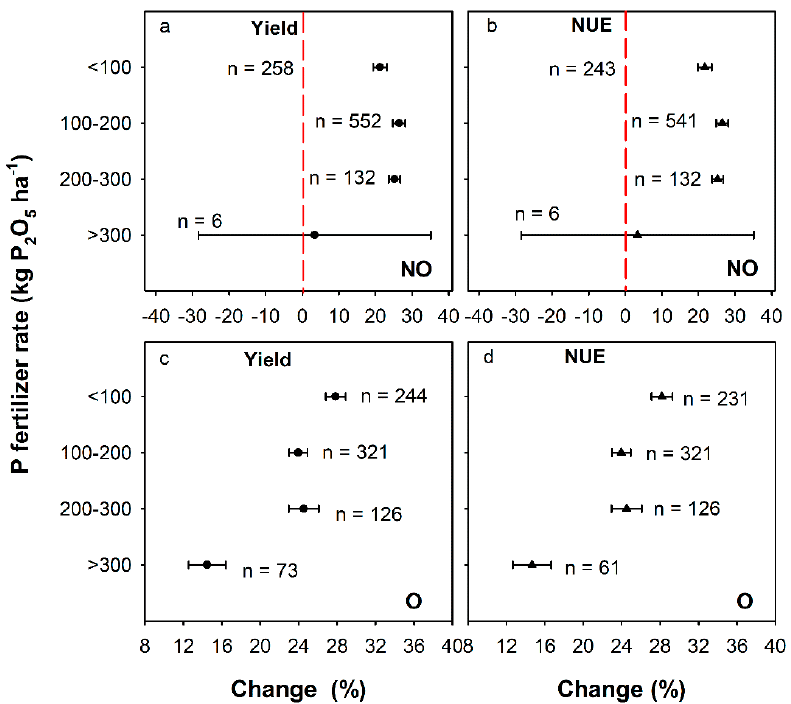
Figure 7. Response of change in potato yield ( a , c ) and NUE ( b , d ) to mulching compared to no mulching at different levels of phosphorus (P) fertilization. Error bars represent 95% confidence intervals. The values for n represent the corresponding number of observations. NO, without organic fertilization; O, with organic fertilization.